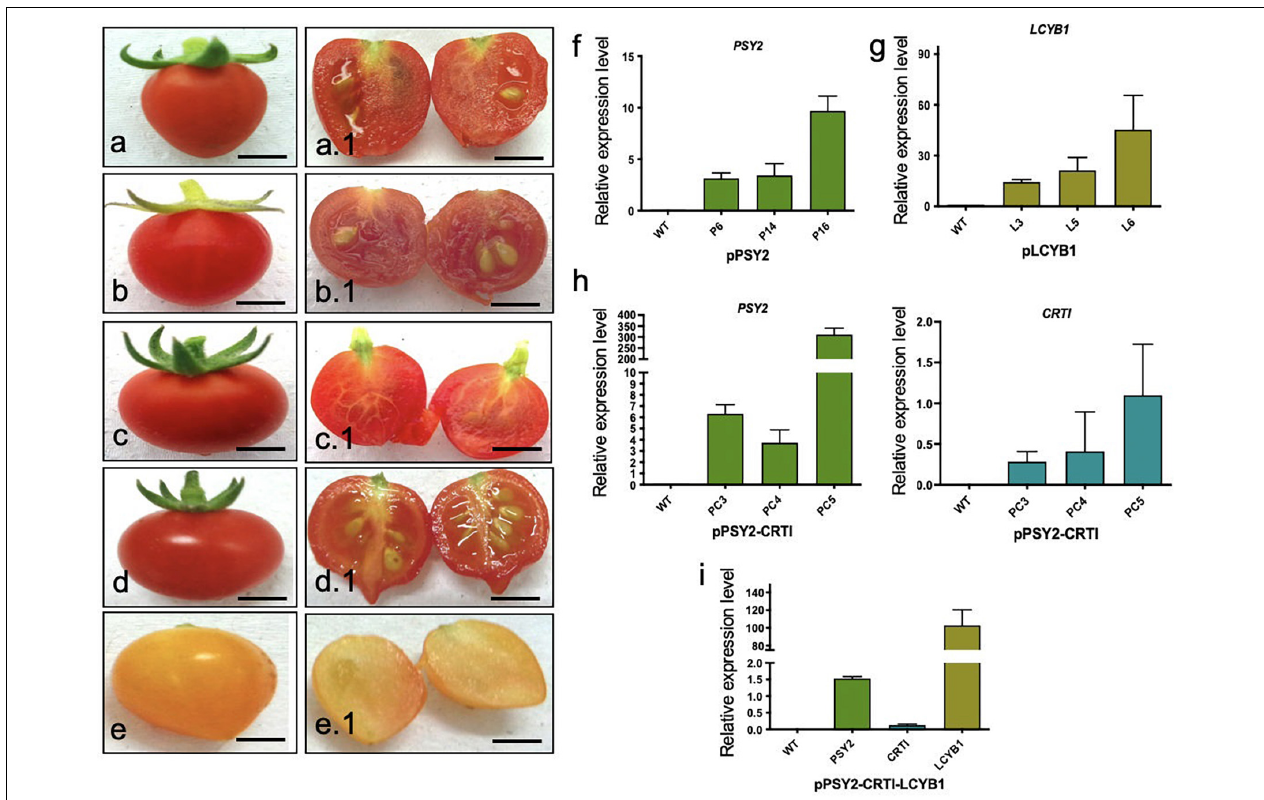
FIGURE 4 | Fruit phenotypes and expression analysis in T1 transgenic fruits. (a) Representative WT tomato fruit. (a.1) Cross-section of (a) . (b) Representative tomato fruit from pPSY2 line. (b.1) Cross-section of (b) . (c) Representative tomato fruit from pLCYB1 line. (c.1) Cross-section of (c) . (c) Representative tomato fruit from pPSY2-CRTI line. (d.1) Cross-section of (d) . (e) Tomato fruit from pPSY2-CRTI-LCYB2. (e.1) cross-section of (e) . Scale bar = 1 cm. (f) q-RTPCR in fruits of pPSY2, (g) pLCYB1, (h) pPSY2-CRTI, and (i) pPSY2-CRTI-LCYB1 transgenic lines. The relative expression was normalized to that of the Actin gene of S. lycopersicum . The expression analysis was performed with three biological replicas (cDNAs) from five fruits, each measured